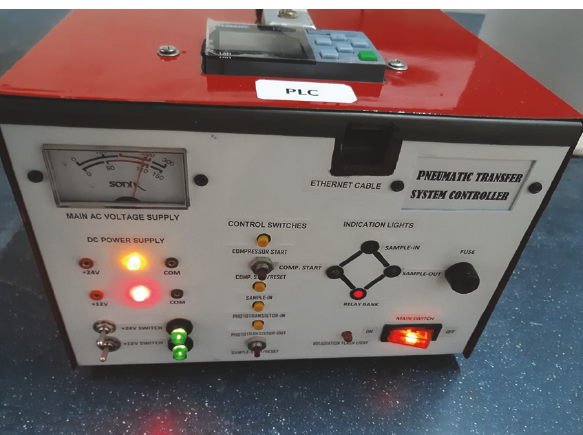
the phototransistor does not switch, and the output indicates 000 volts; see Figure 19. Bulbs for S 2 and S 4 of Figure 20 are “ON” to indicate that sample-out solenoid valves are opened to transfer the irradiation sample onto the High Purity Germanium (HPGe) detector for counting. The green